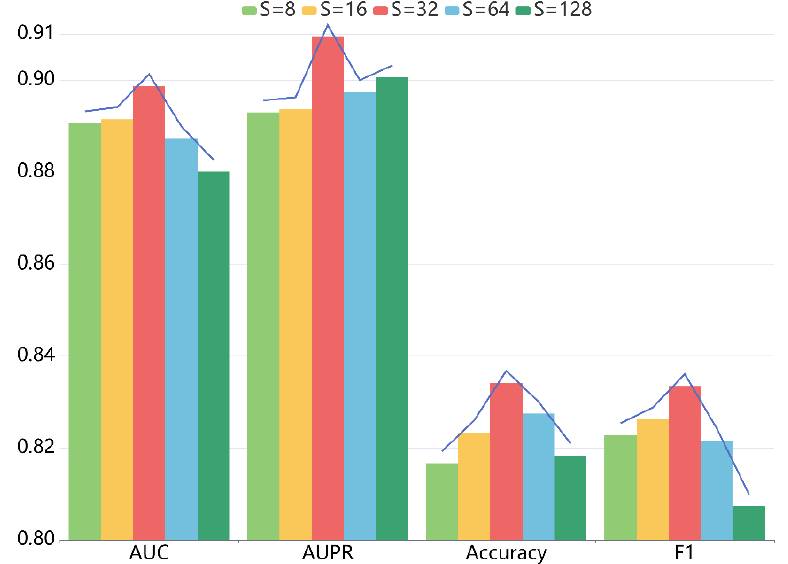
Figure 4. Effects of embedding size S on the performance of LRGCPND.